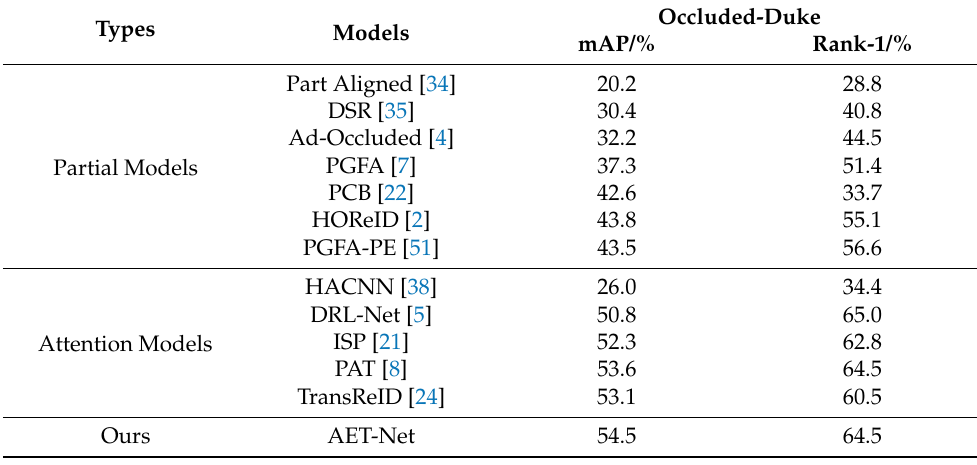
Table 3. The performance comparison between our proposed model and state-of-the-art models on the